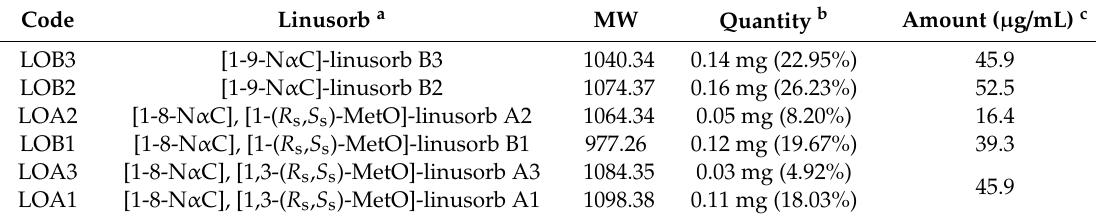
Table 2. The composition of linusorb mixture (LOMIX) by HPLC.